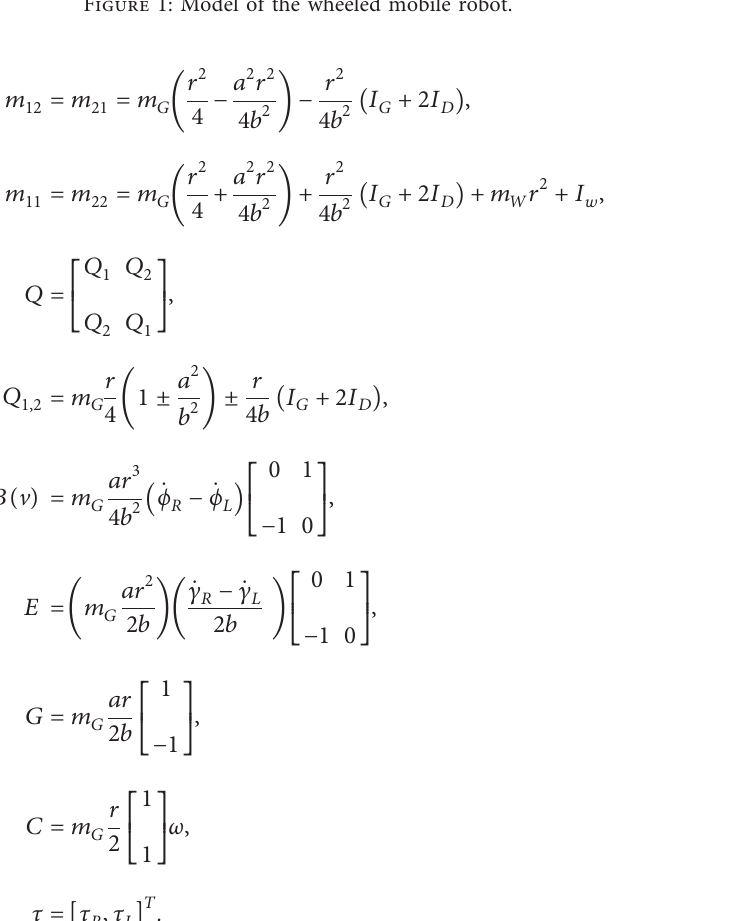
Figure 1: Model of the wheeled mobile